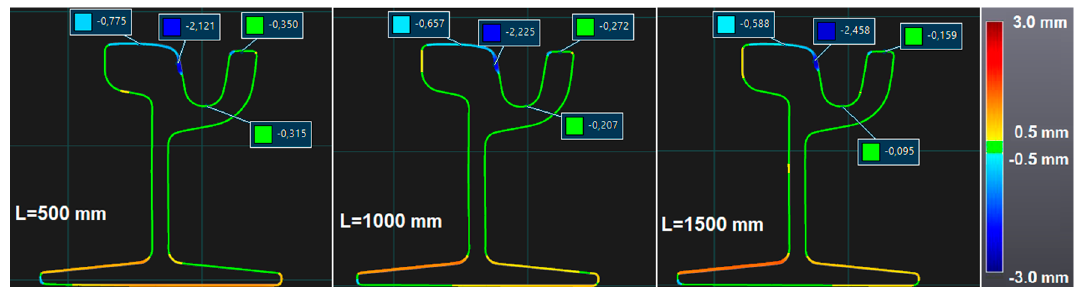
Figure 17. Inspected cross-sections.